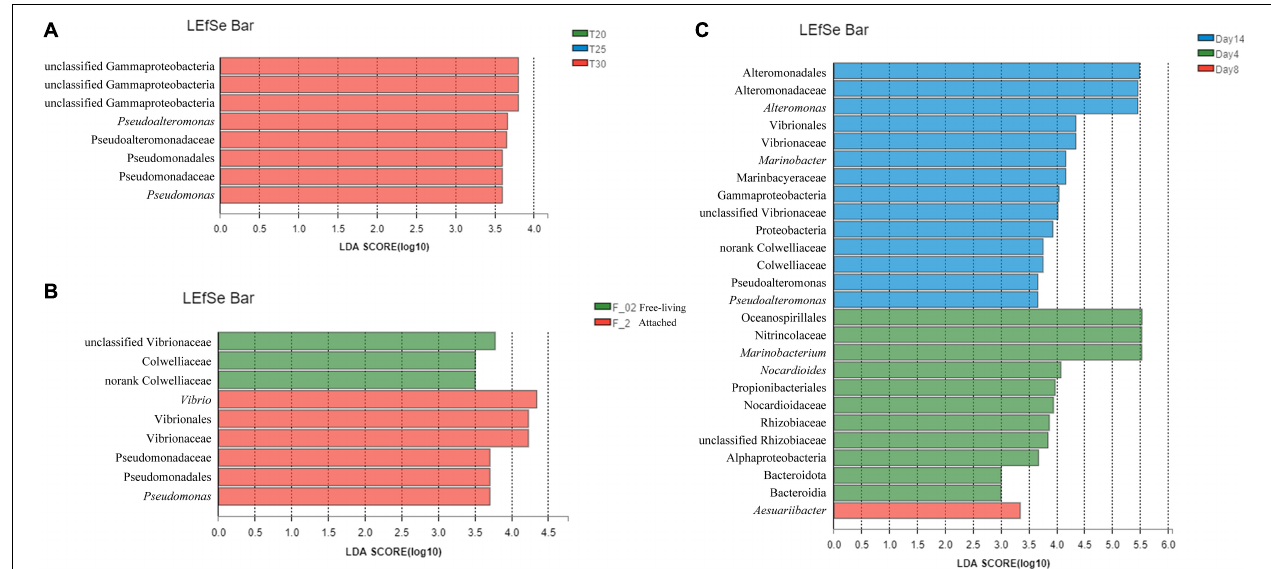
FIGURE 4 | Taxa differentially abundant at (A) different temperatures in (B) free-living and attached bacteria, and at (C) different culturing time points based on the LEfSe analysis.